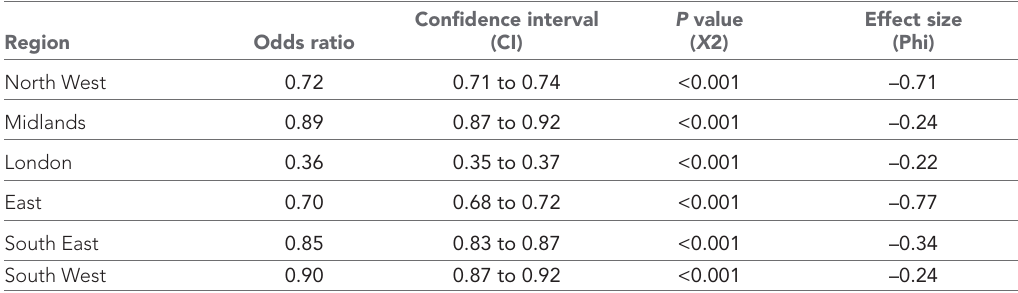
Table 2 Vaccination uptake by region using North East England and Yorkshire as a